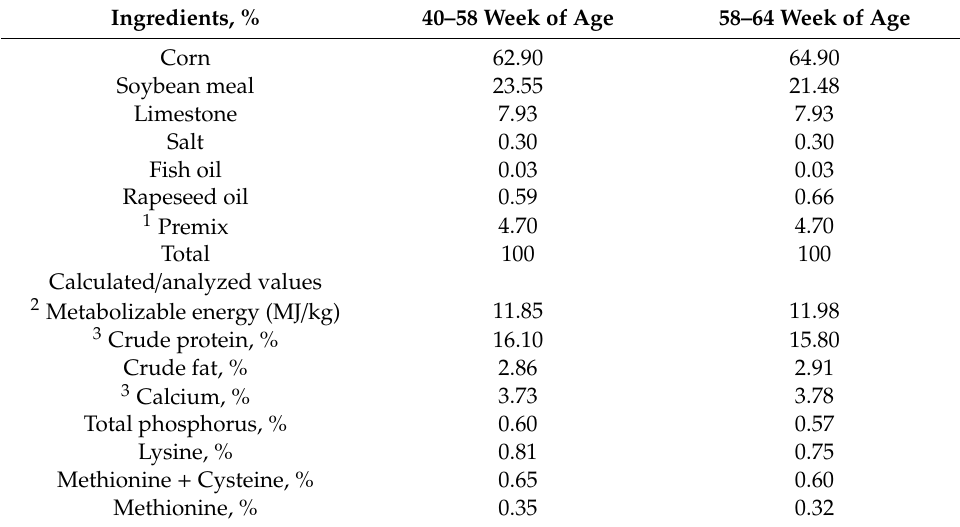
Table 1. Composition and nutrient level of the basal diet for 2 sub-trials (as